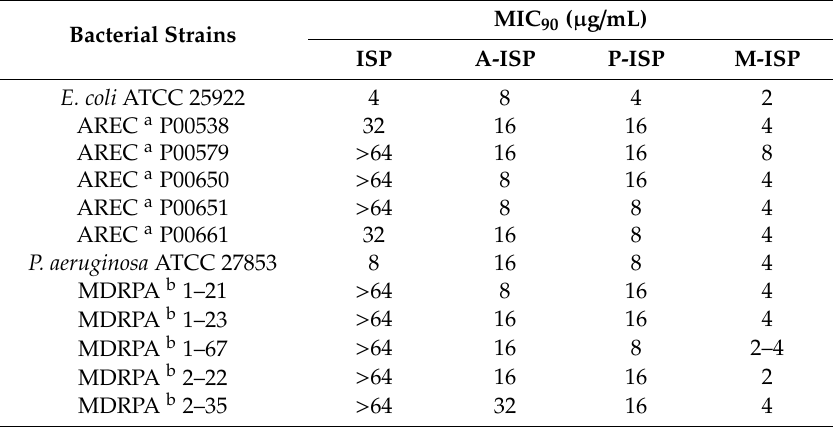
Table 2. Antibacterial activity of ISP and its